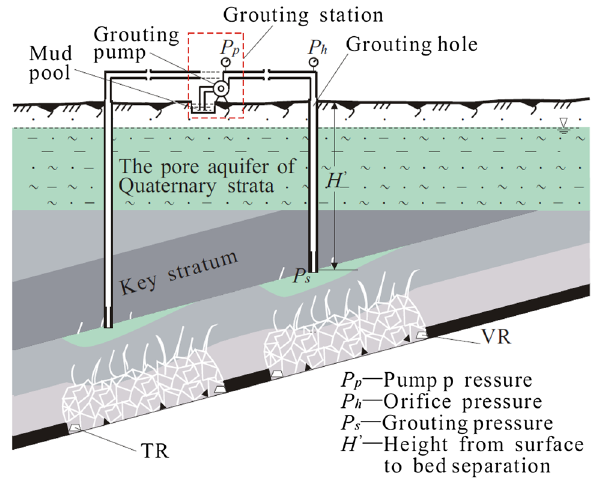
Fig. 5 Diagram of grouting technique